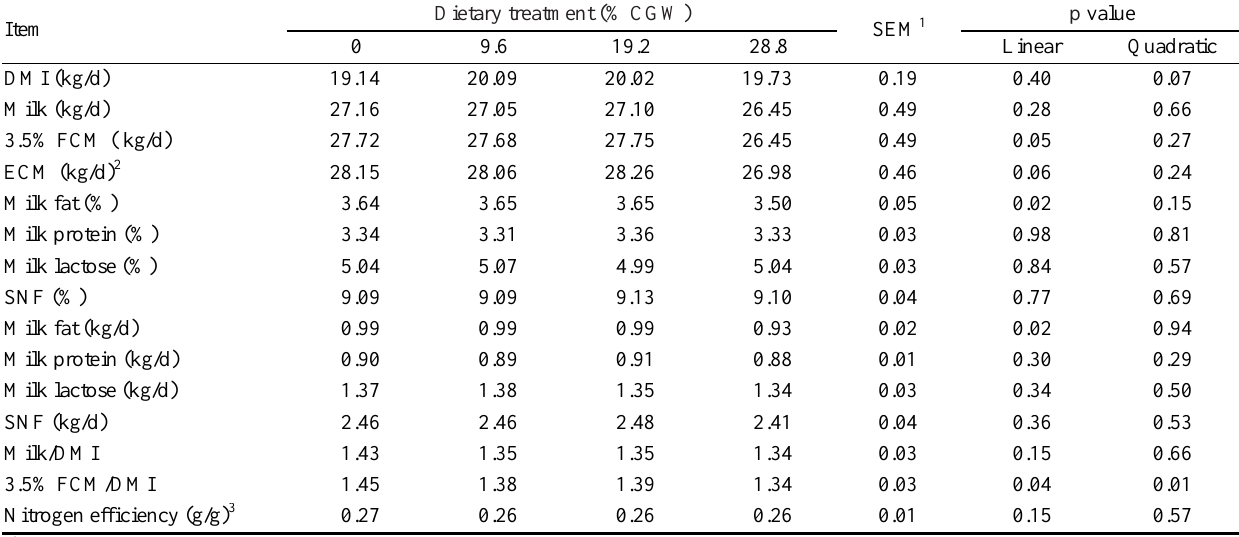
Dietary treatment (% CGW)